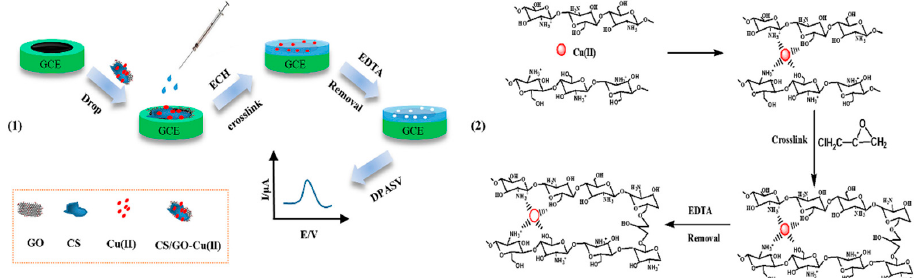
Figure 7. Schematic diagram of the fabrication procedure for CS/GO-IIP/GCE (1) and the corre- sponding chemical processes involved (2). Note: the outer green layer is not GCE but the electrode insulation; GCE is the black inner disk. Reprinted with permission from Ref. [65]. Copyright 2019, Elsevier. Table 2. Summary of the HMIIECSs prepared by